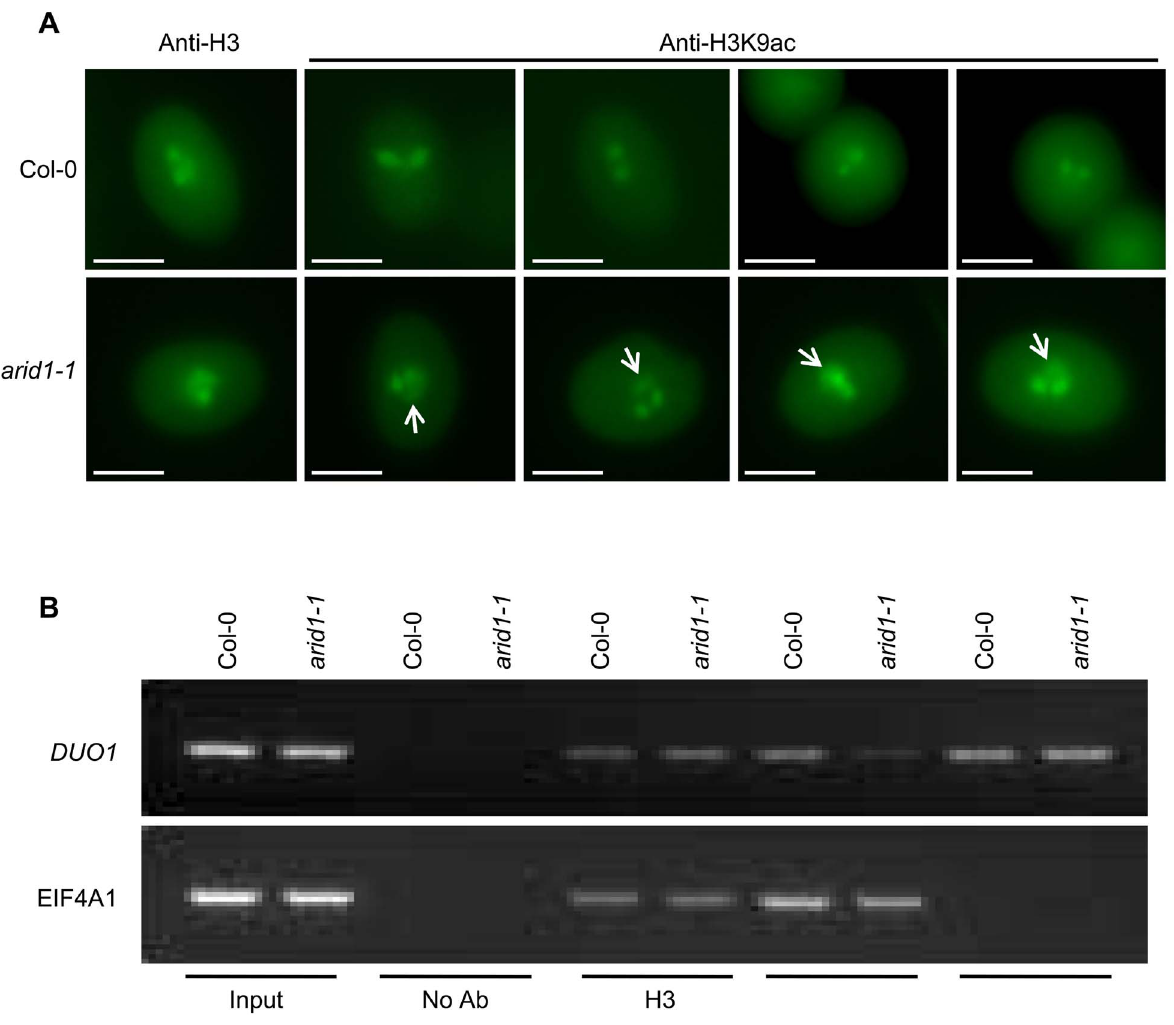
Figure 6. Altered histone acetylation in arid1-1 . (A) Expanded pattern of histone acetylation signal in arid1-1 by immunofluorescence analysis. Mature pollen from wild type and arid1-1 plants was incubated with anti-H3 (control) and anti-H3K9ac antibodies. Representative examples for arid1- 1 show histone acetylation in the vegetative nucleus (indicated by white arrowheads). 50–100 pollen grains for each genotype were examined. (B) Reduced histone acetylation at the DUO1 promoter in the arid1-1 mutant by ChIP. Inflorescences from wild type and arid1-1 were used for a ChIP assay with anti-H3, anti-H3K9ac, and anti-H3K4me3 antibodies. ChIP-DNA was used for PCR by amplifying 35 cycles for both EIF4A1 (negative control) and the DUO1_3 fragment, which bound ARID1. Similar results were obtained from three independent biological replicates; the results shown are from one replicate.